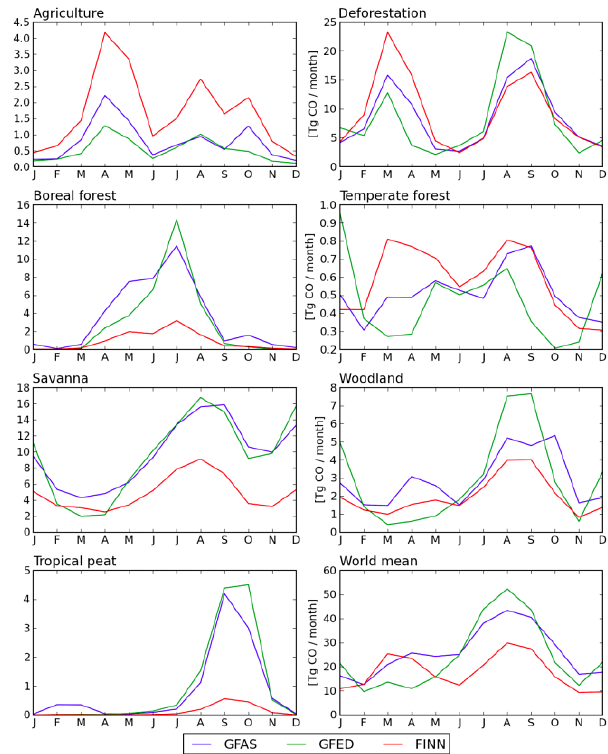
Figure 18. Mean seasonal CO emissions for seven biomes associ- ated with dominant fire type in GFED (see Fig. 17) and the world for 2003 until 2011. Emissions are shown for three different fire emission inventories: GFAS, GFED and FINN (Kaiser et al.,